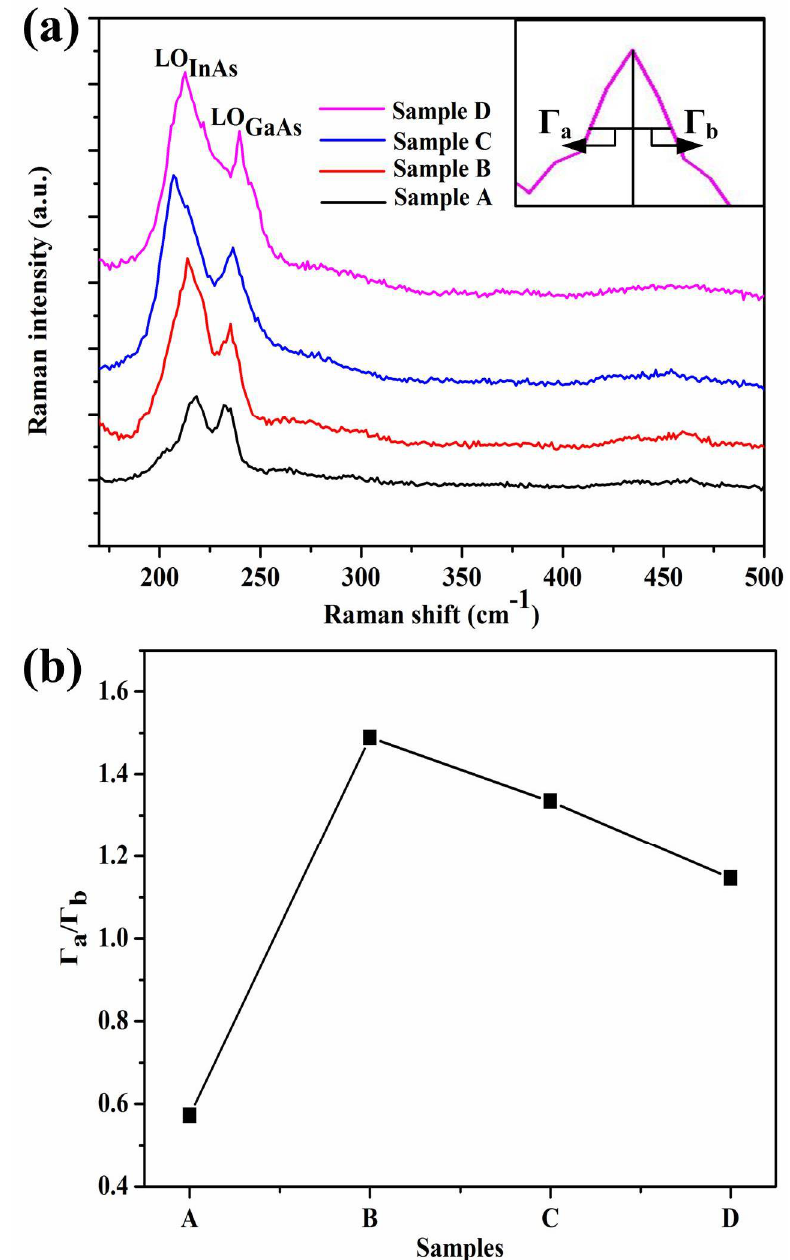
Figure 4. ( a ) Raman spectra of In 0.82 Ga 0.18 As epitaxial layers grown on InP (100) substrates for samples A–D. The inset shows Γ a and Γ b which is used in the asymmetric ratio (Γ a /Γ b ) of Raman scattering spectra; ( b ) line chart of the variation of asymmetric ratio (Γ a /Γ b ) for samples A–D.